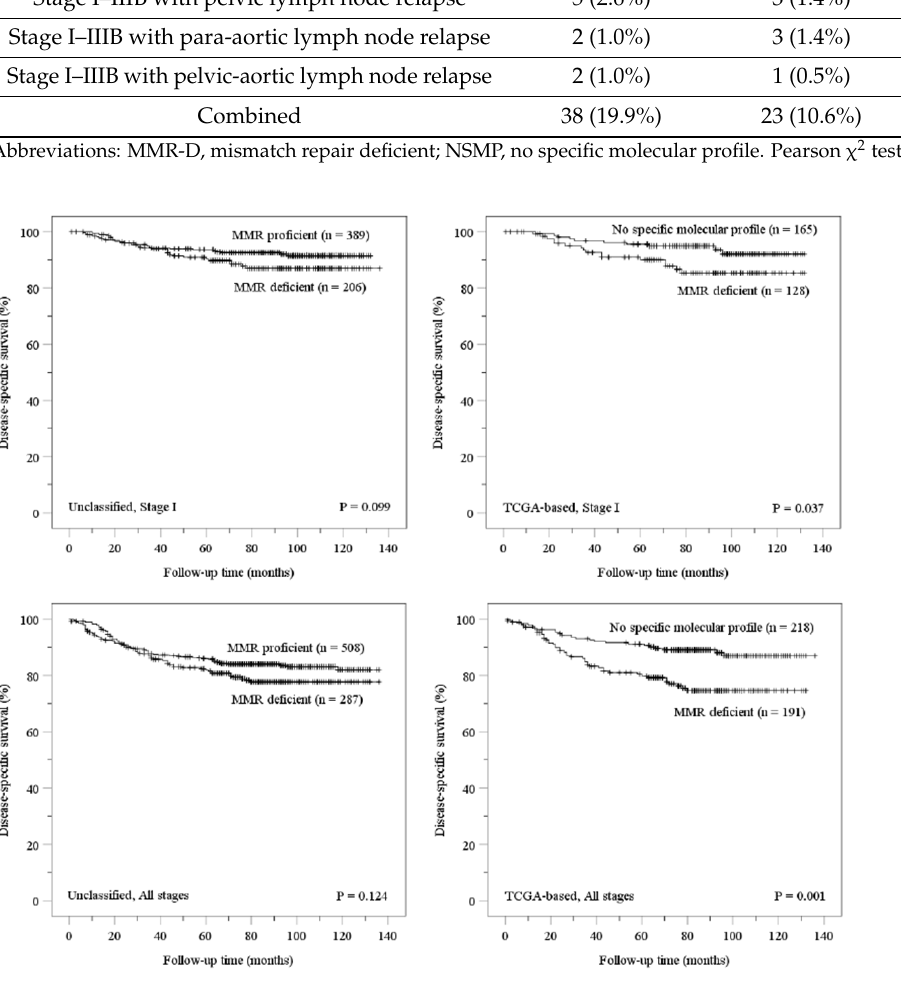
Figure 1. Kaplan–Meier estimations for disease-specific survival in patients with stage I or stage I–IV endometrial carcinoma according to the presence of mismatch repair deficiency. Abbreviations: MMR, mismatch repair; TCGA, The Cancer Genome